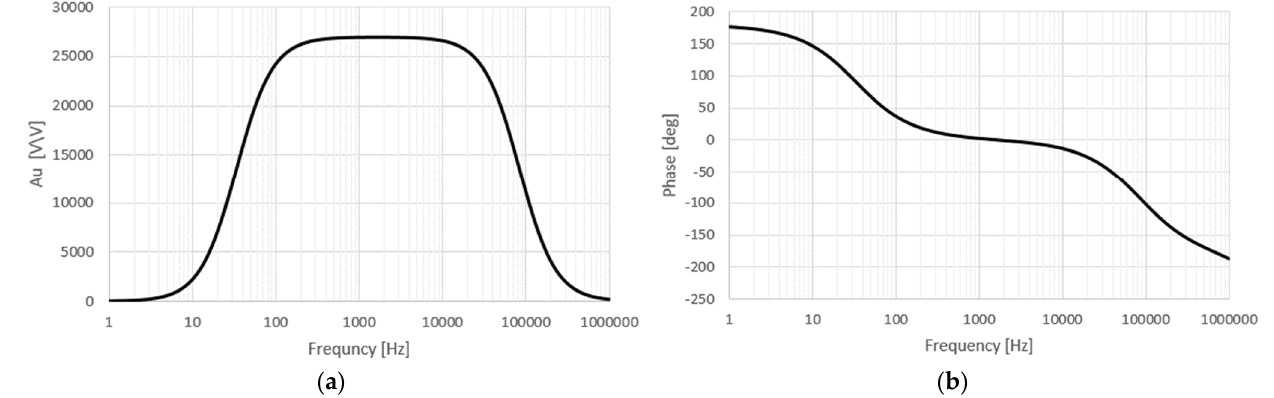
Figure 6. Frequency characteristics of the electromagnetic field receiver: ( a ) amplitude for Au = 27000 V/V, ( b ) phase.